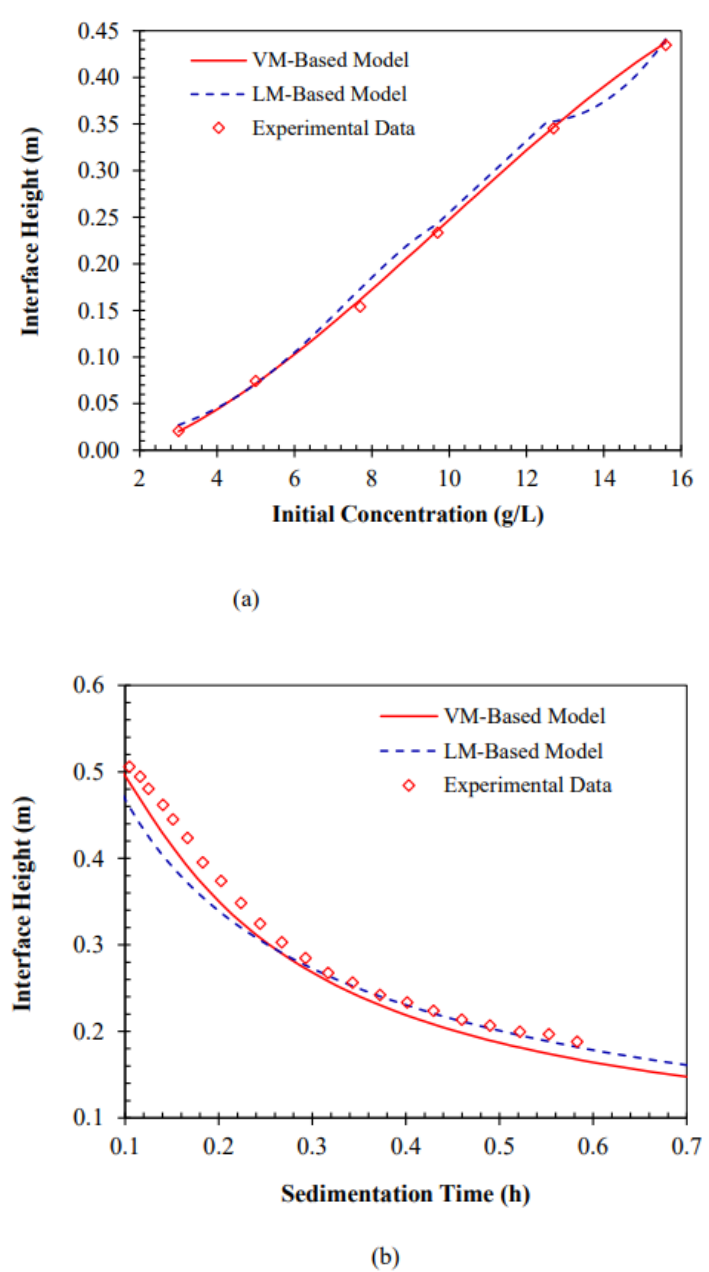
Figure 8. Sensitivity analysis of the isolated effect of ( a ) initial concentration and ( b ) time on the interface height while the other input parameter remains constant at its mean